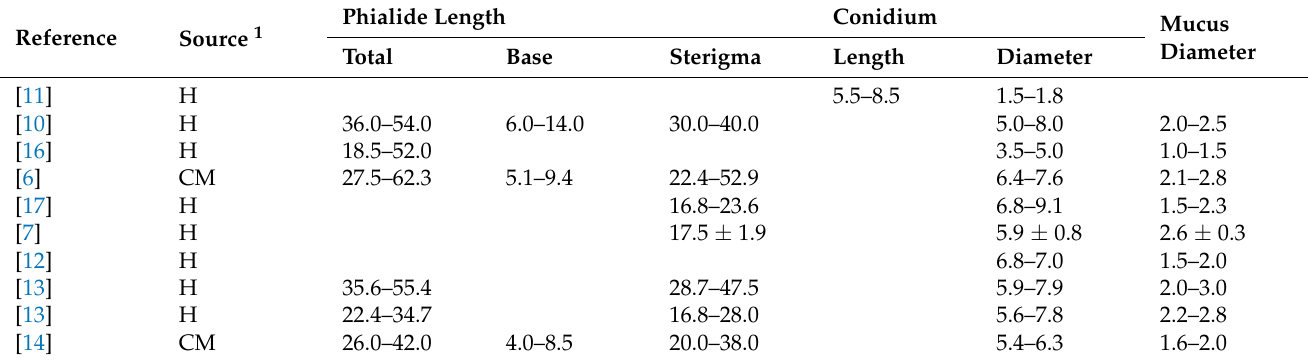
Figure 2. Mexican Hirsutella strains morphological characteristics. ( A ) Phialide length, ( B ) conid- ium width, ( C ) conidium length, ( D ) conidium width, including the mucilaginous envelope, and ( E ) conidium length, including the mucilaginous envelope. Measurements are in micrometers. Table 1. Most representative reported Hirsutella citriformis structure measurements ( µ m).